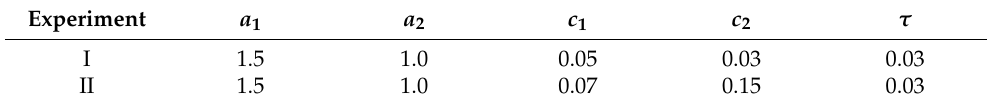
Table 1. Parameter values for the numerical experiment.